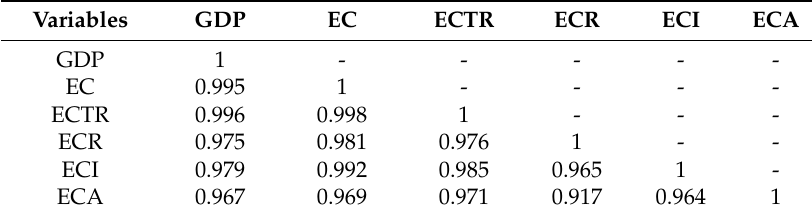
Table 1. Correlation matrix: Energy consumption and economic growth in Mexico.